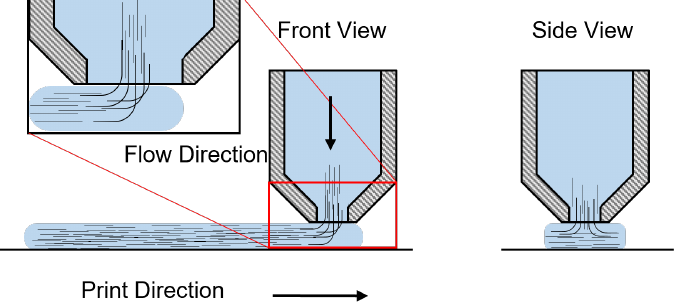
Figure 9. Schematic of fiber alignment during deposition of extruded